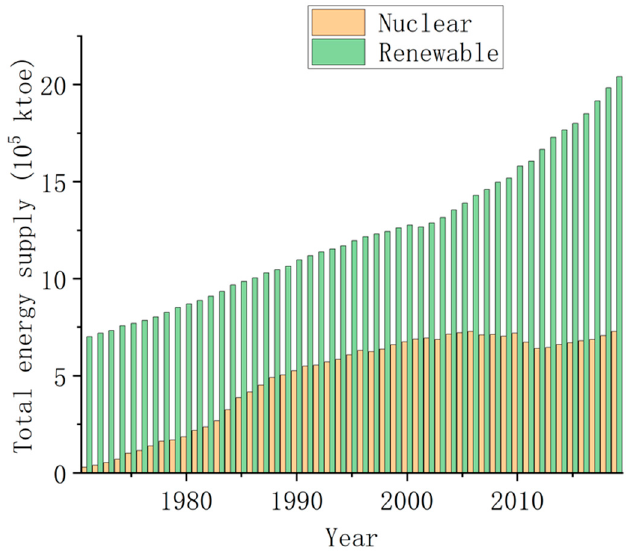
Figure 3. The total energy supply of nuclear and renewables from 1971 to 2019.